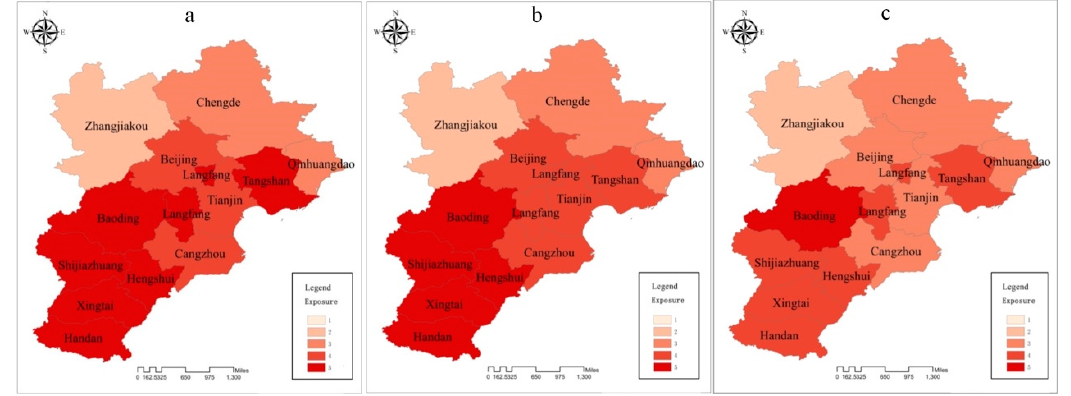
Figure 3. Individual assessment indices of exposure: ( a ) 2013; ( b ) 2014; ( c ) 2015.